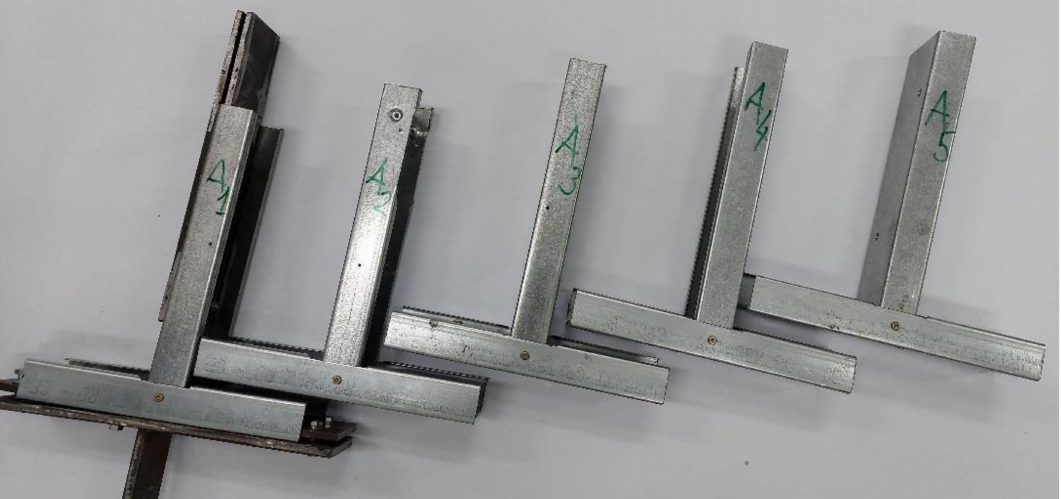
Figure 7. Specimens for A joint.